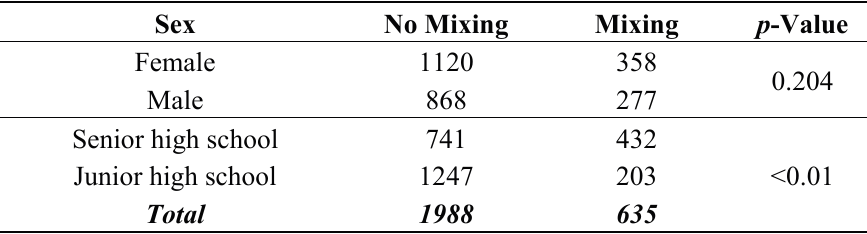
Table 4. Number of students mixing energy drinks with alcohol.